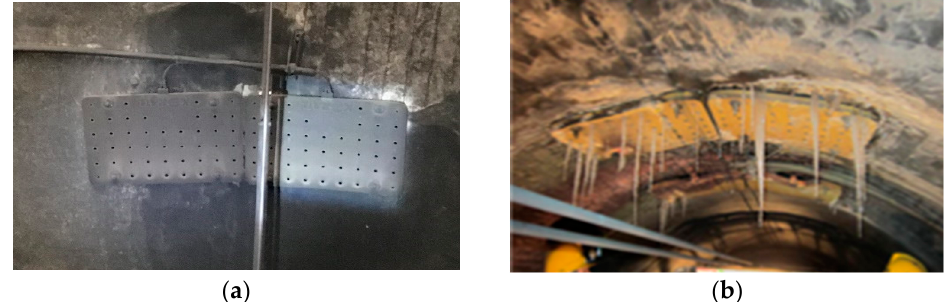
Figure 2. Examples of conventional automated icicle removal device installations: ( a ) example installation of ordinary icicle removal device; ( b ) icicle formation on the joint part of an icicle removal device.